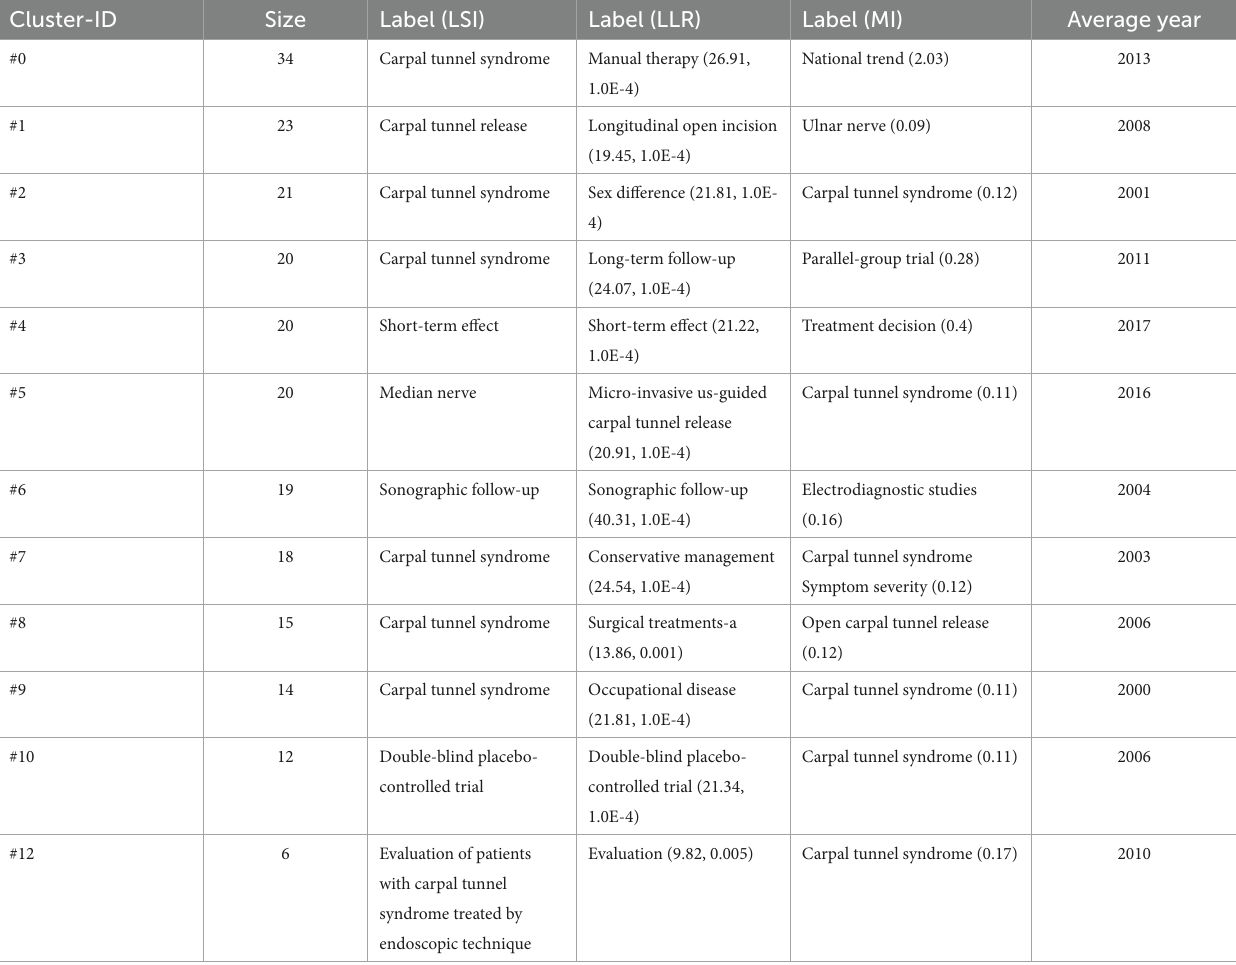
TABLE 3 Keyword clustering labels for research areas on surgical treatment of carpal tunnel syndrome from 2003 to 2022.